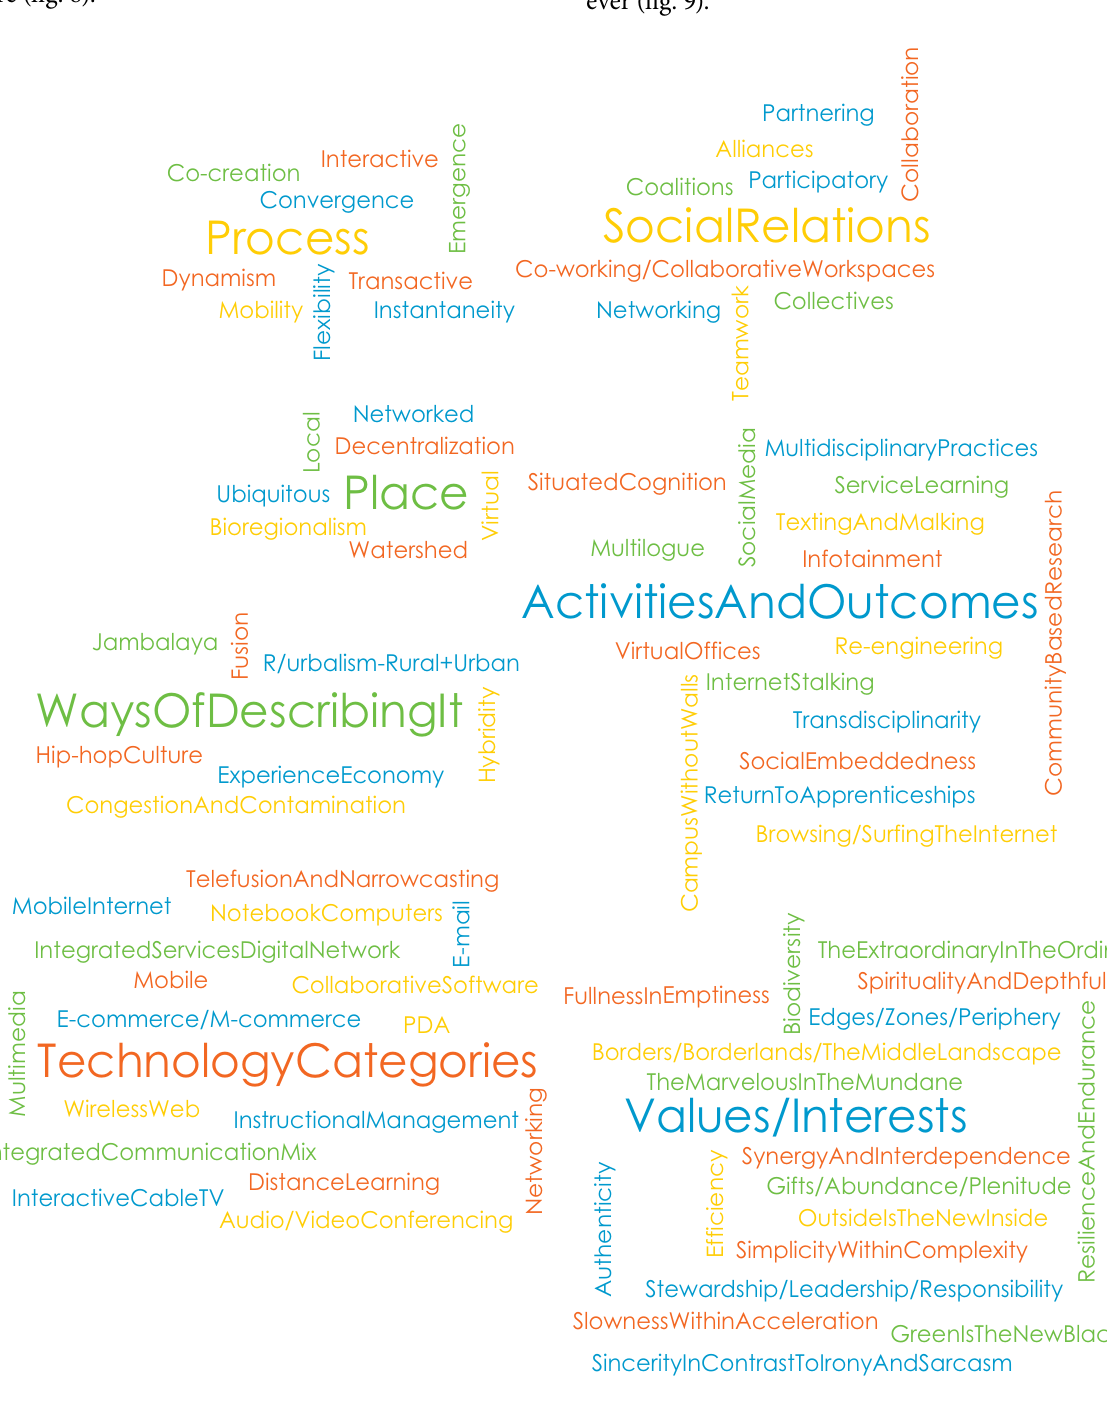
Fig. 8. Keywords and characteristics of the new paradigm as word